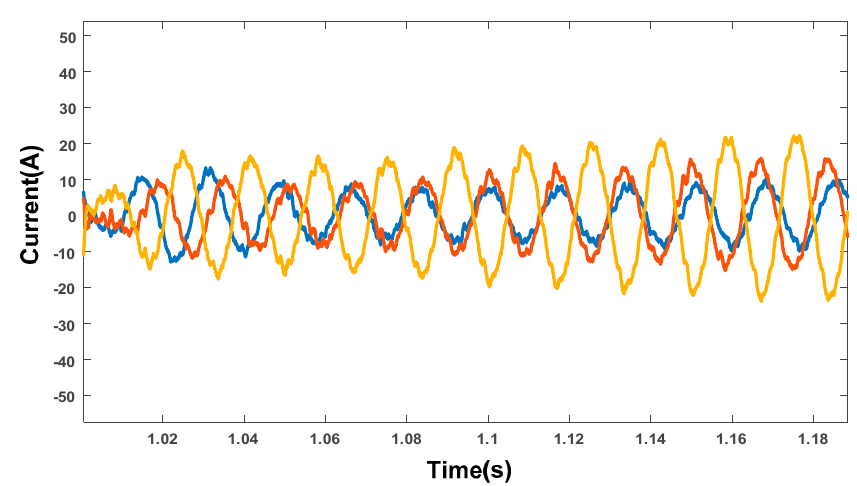
Figure 21. The current at the grid side with an imbalanced load.